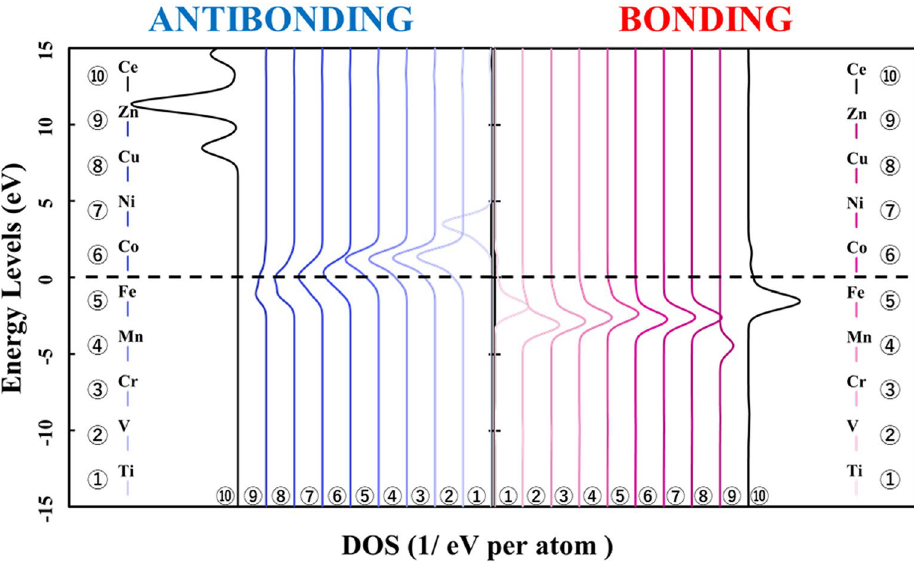
Figure 9. Energy levels of the bond composition between the metal 3d orbitals and the oxygen 2p orbitals are based on the reference level as the HOMO level in the M@Ce 12 O 8 36+ cluster model (M = Ti, V, Cr, Mn, Fe, Co, Ni, Cu, Zn, Ce). The bond composition between the metal 5d orbitals and the oxygen 2p orbitals are in the undoped ceria. The bonding and antibonding orbital components are on the right and left sides,